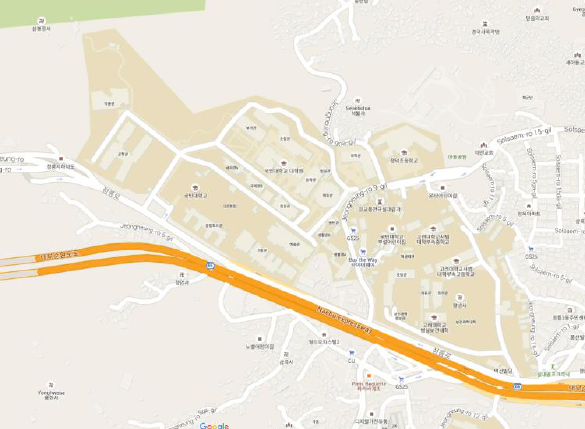
Figure 6. Survey area, includes Kookmin University Campus and the surrounding area.